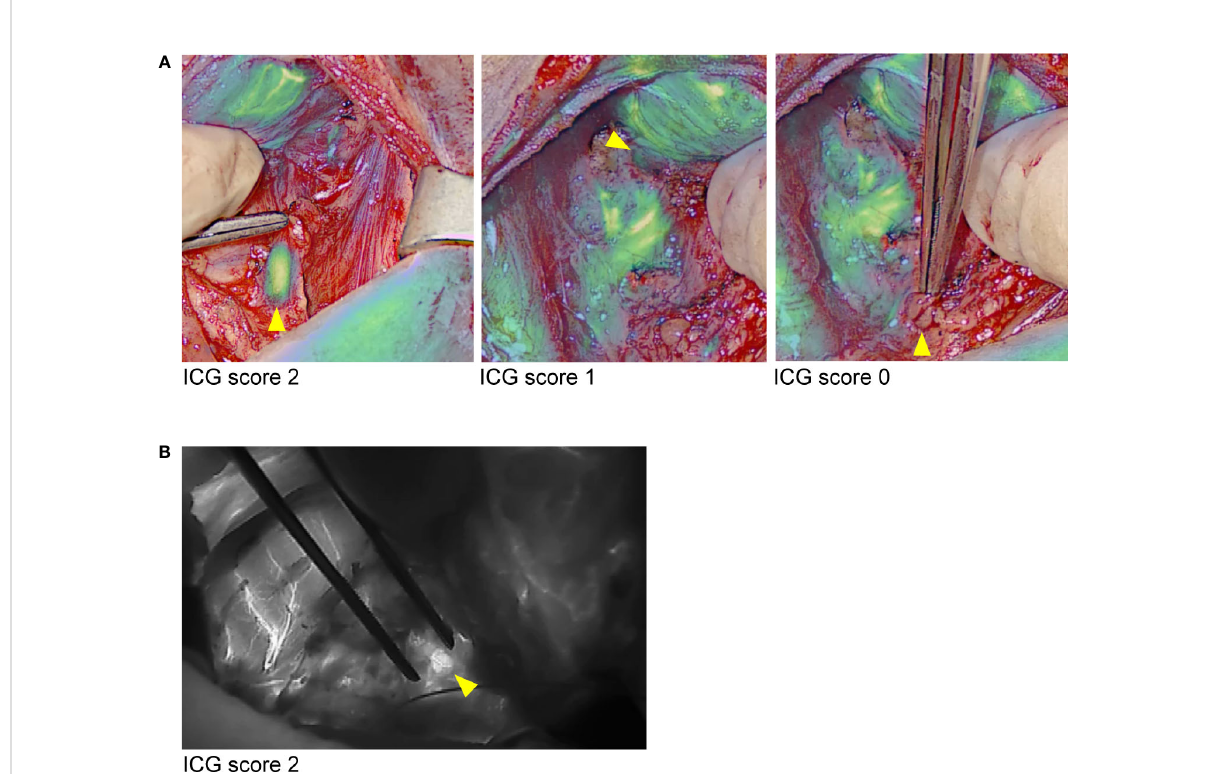
FIGURE 3 Comparison of images generated during ICG angiography with the different fl uorescence imaging systems. (A) EleVision IR; Overlay of white light and monochrome fl uorescence images; (B) FLUOBEAM LX; yellow arrows indicate parathyroid